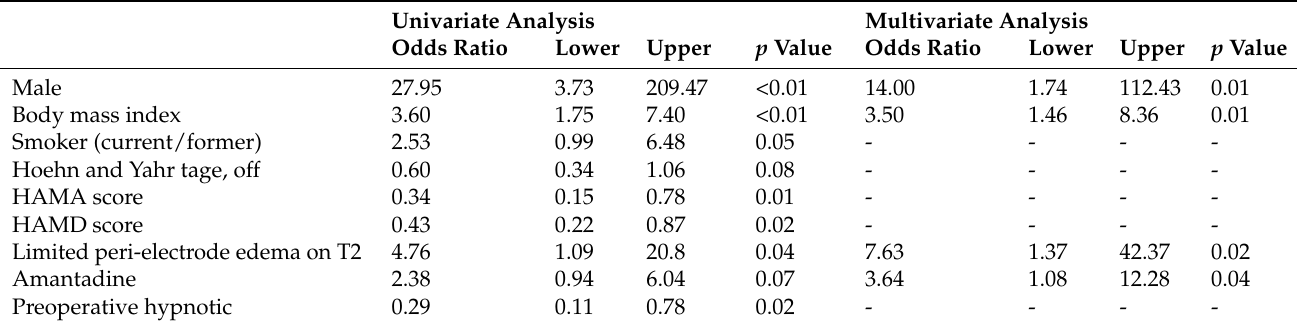
Table 2. Univariate and multivariate analyses of postoperative hiccups in PD patients after STN-DBS under general anesthesia.